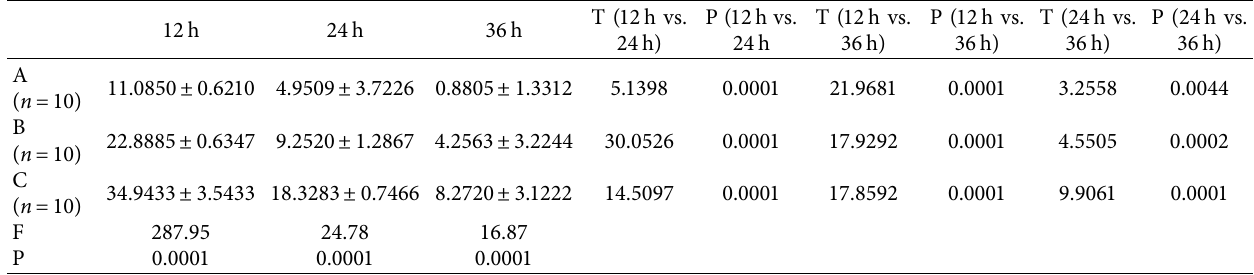
Table 1: The area of unhealed corneal epithelium in each group at 12h, 24 h, and 36h after corneal epithelium removal.